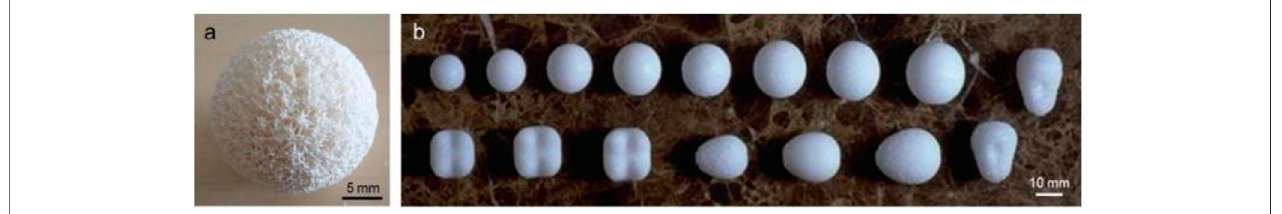
FIGURE 5 | Example of porous orbitals: (A) coralline HA sphere and (B) various porous PE implants. Reproduced with permission from (Jordan et al., 2010).